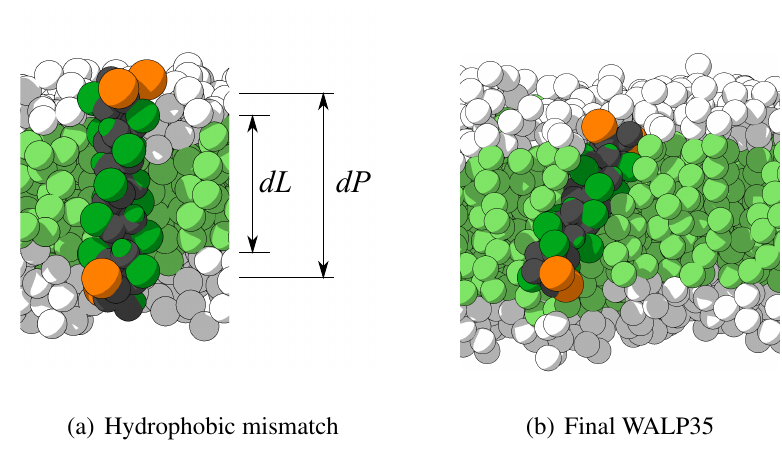
Figure 9. Configurations for different WALPs. In (a) the initial configuration for WALP27 embedded in an H4T3T3 lipid membrane is shown, with the thickness of the hydrophobic part of the membrane ( dL ) and the hydrophobic part of the peptide ( dP ) indicated. In (b) the final configuration for WALP35 in an H4T4T4 lipid membrane are depicted. In each figure water and some lipids are removed for